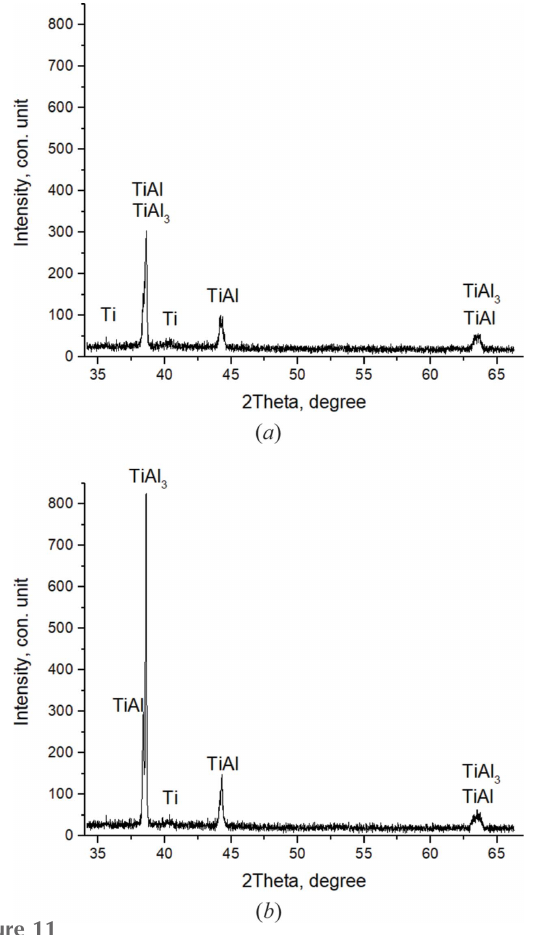
Figure 11 Diffractograms of the 32nd ( T = 1406.5 (cid:3) C) ( a ) and the 33rd ( T = 1465.6 (cid:3) C) ( b )